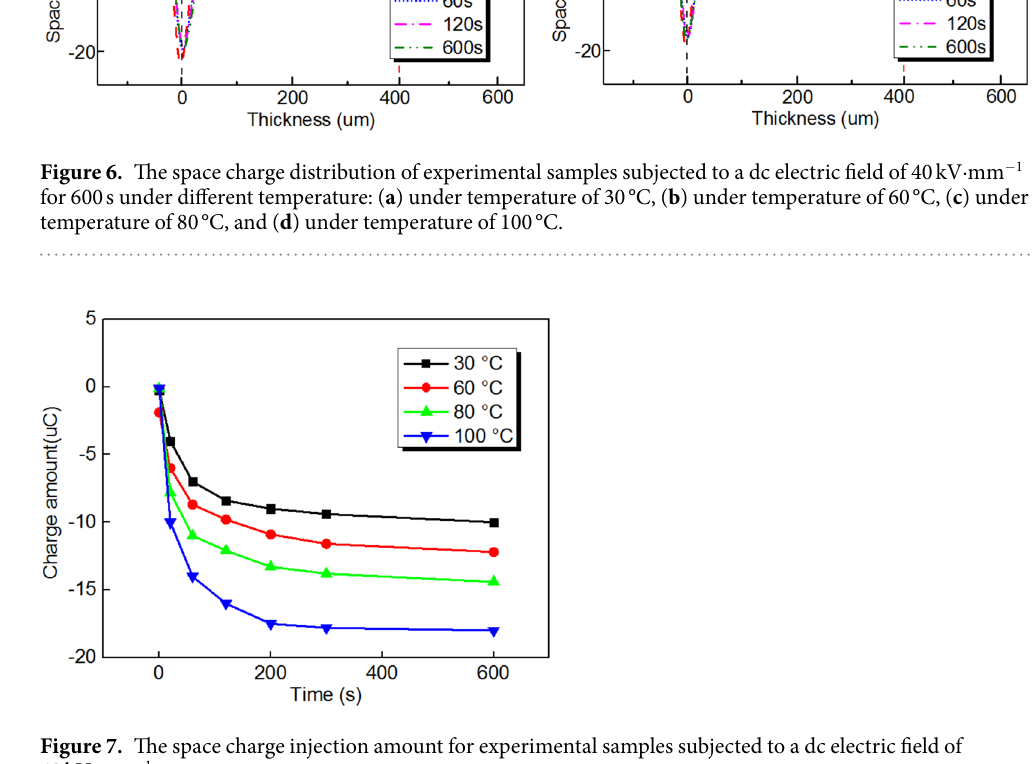
Figure 7. The space charge injection amount for experimental samples subjected to a dc electric field of 40 kV·mm − 1